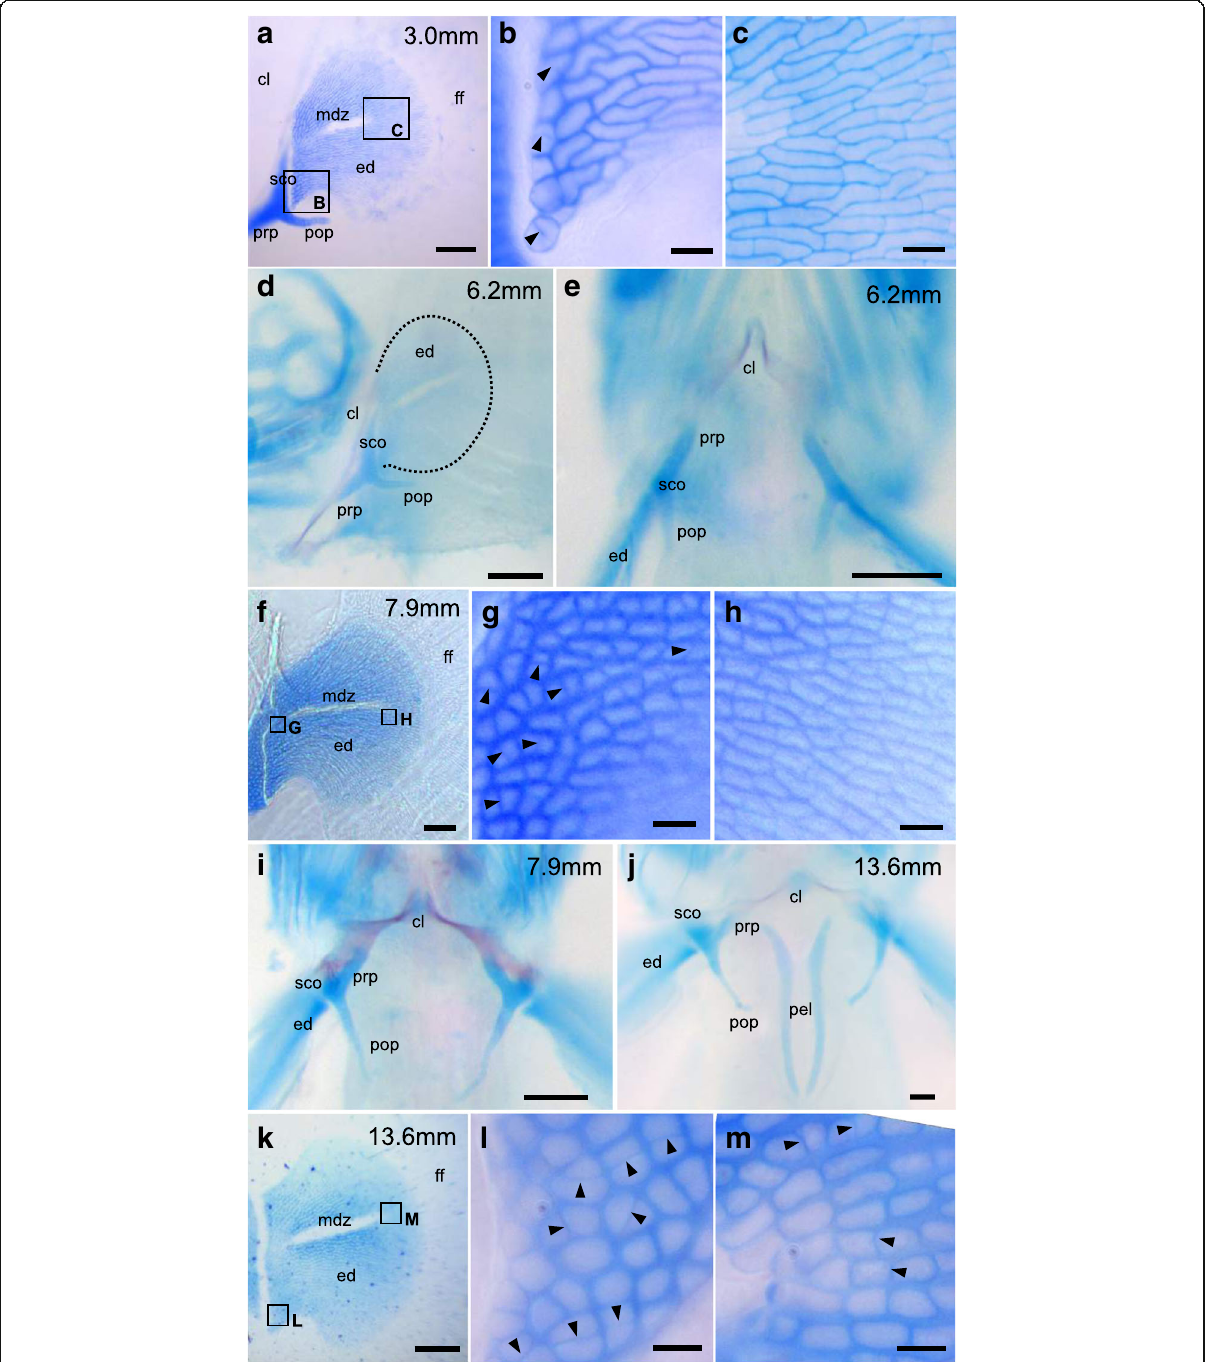
Fig. 5 Skeletal patterns of pectoral fins of larvae. Lateral ( a – d , f – h , k – m ) and ventral views ( e , i , j ) of pectoral fins of planktonic larvae at 3.0 – 13.6 mm TL stained with alcian blue and alizarin red ( n =1 each stage). b , c , g , h , l , m Magnified views from the indicated images. Arrowheads in ( b , c , g , h , l , m ) indicate thin matrix septa within dividing cells. cl, cleithrum; ed., endoskeletal disc; ff, fin fold; mdz, zone of matrix decomposition; pop, postcoracoid process; prp, precoracoid process; pel, pelvic bone primordium; sco, scapulocoracoid. Scale bars, 100 μ m in ( d , e , i , j ); 50 μ m in ( a , f , k ); 10 μ m in ( b , c , g , h , l , m